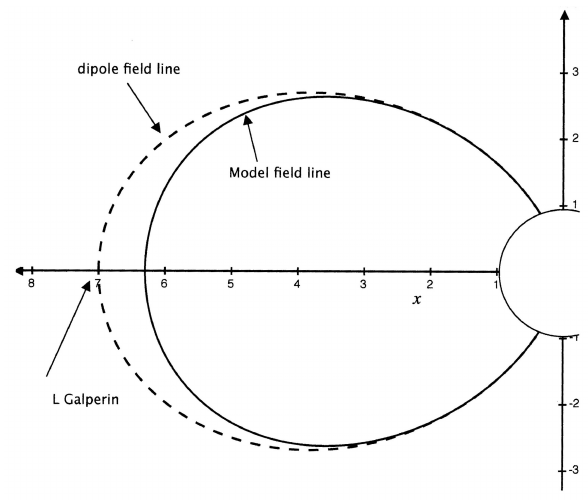
Fig. 3. The model field line is approximated by a dipole field line Fig.3 : The model field line is approximated by a dipole field line of label L , here the Galperin L parameter. This dipole field line corresponds to the first term in equation 6a. The of label L , here the Galperin L parameter. This dipole field line additional correcting terms in equation 6a correspond to the distortion of the dipole magnetic corresponds to the first term in Eq. (6a). The additional correcting field to give the model field line of label L . terms in Eq. (6a) correspond to the distortion of the dipole magnetic field to give the model field line of label L